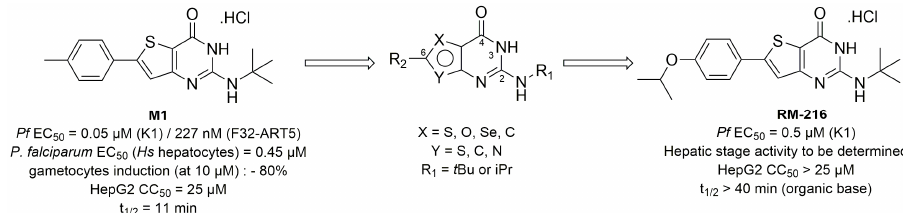
Figure 35. Structure of Hit M1 and chemical modulation at position 6 of the scaffold.